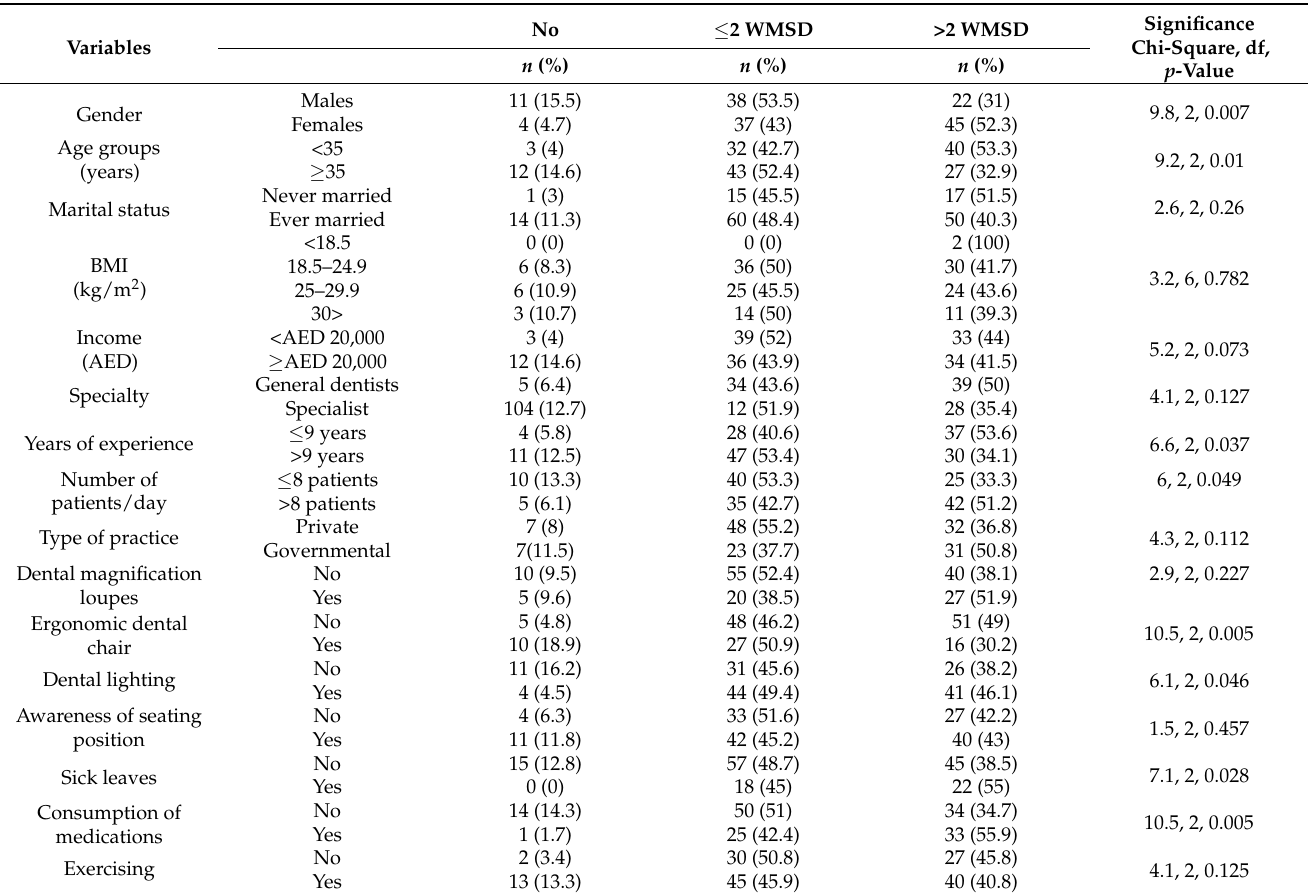
Table 3. Frequency of WMSD by sociodemographic and work-related characteristics ( n =